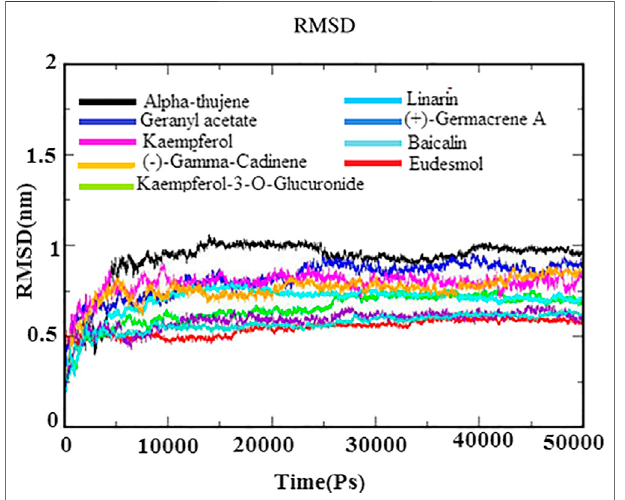
FIGURE5 | RMS fl uctuation plot forN-protein – inhibitor complexes(nine complexes) during the 50 ns simulation as a function of the number of